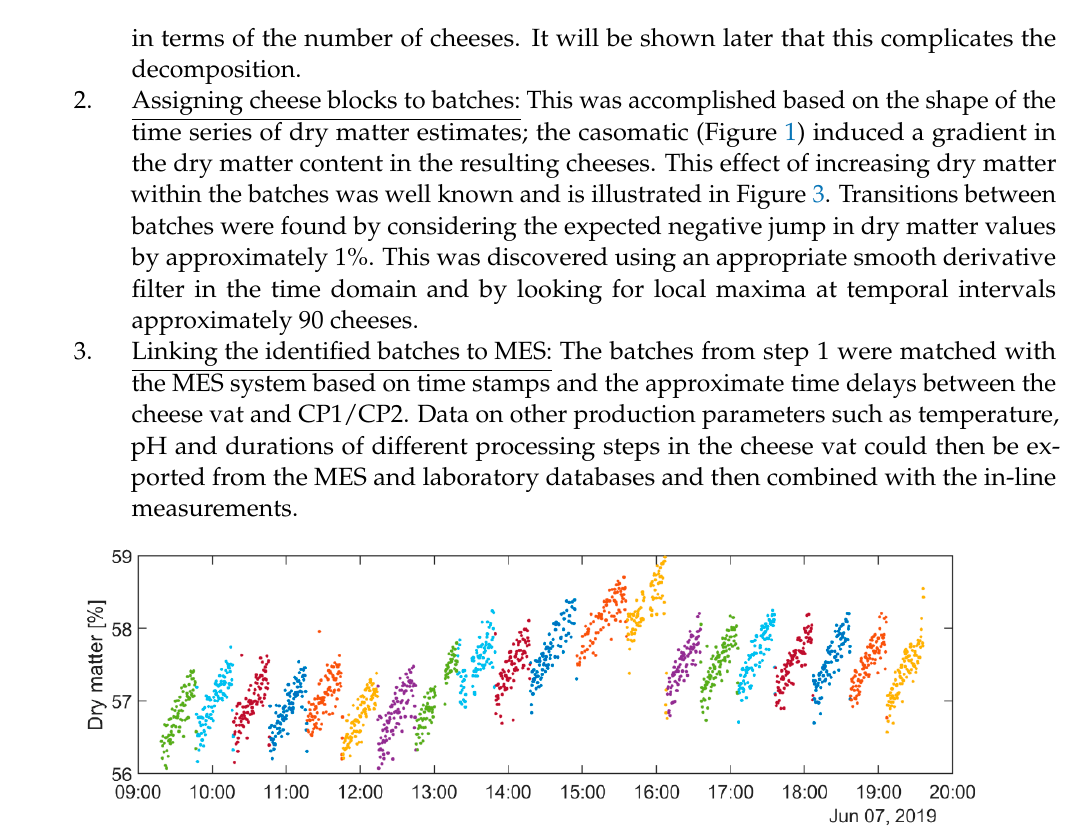
Figure 3. In-line estimates of dry matter at CP1 for a randomly selected production day in 2019. The colours indicate grouping into batches, identified based on the well-known gradient in dry matter within each batch caused by the casomatic.